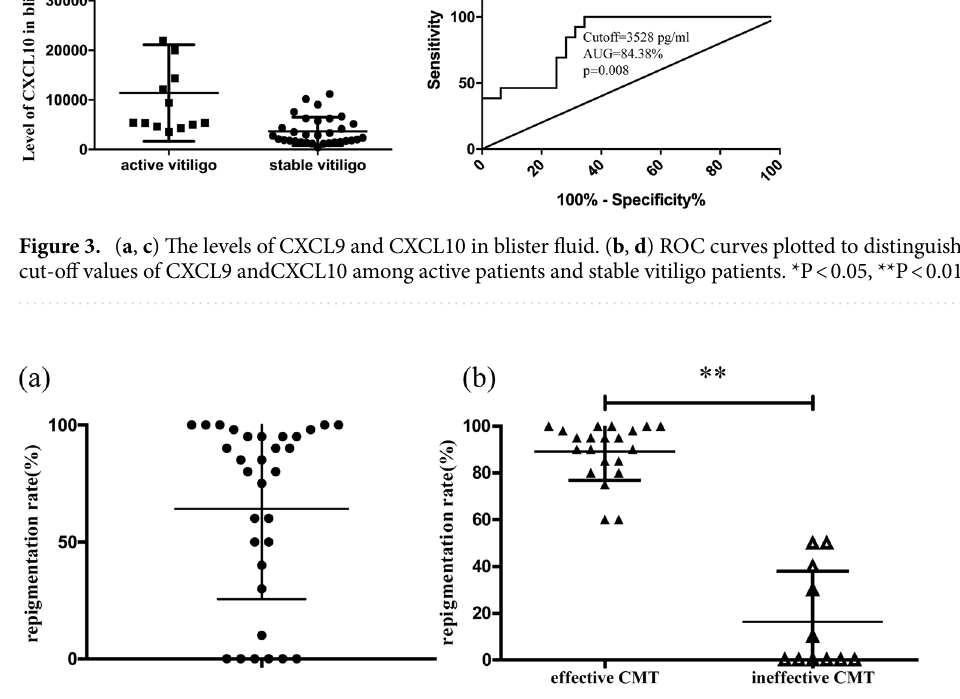
Figure 4. ( a )There pigmentation rate in stable vitiligo patients (n = 32). ( b ) Statistics of differences between groups of different CMT effects. *P < 0.05, **P < 0.01.